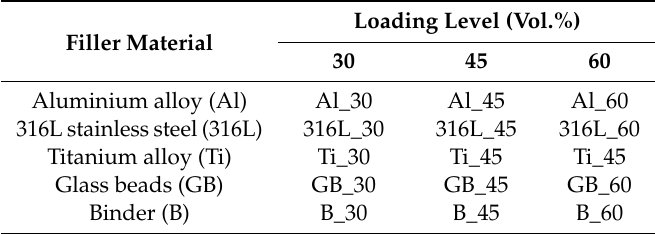
Table 3. Combinations of the prepared highly filled composites and their designated names. Loading Level (Vol.%) Filler Material